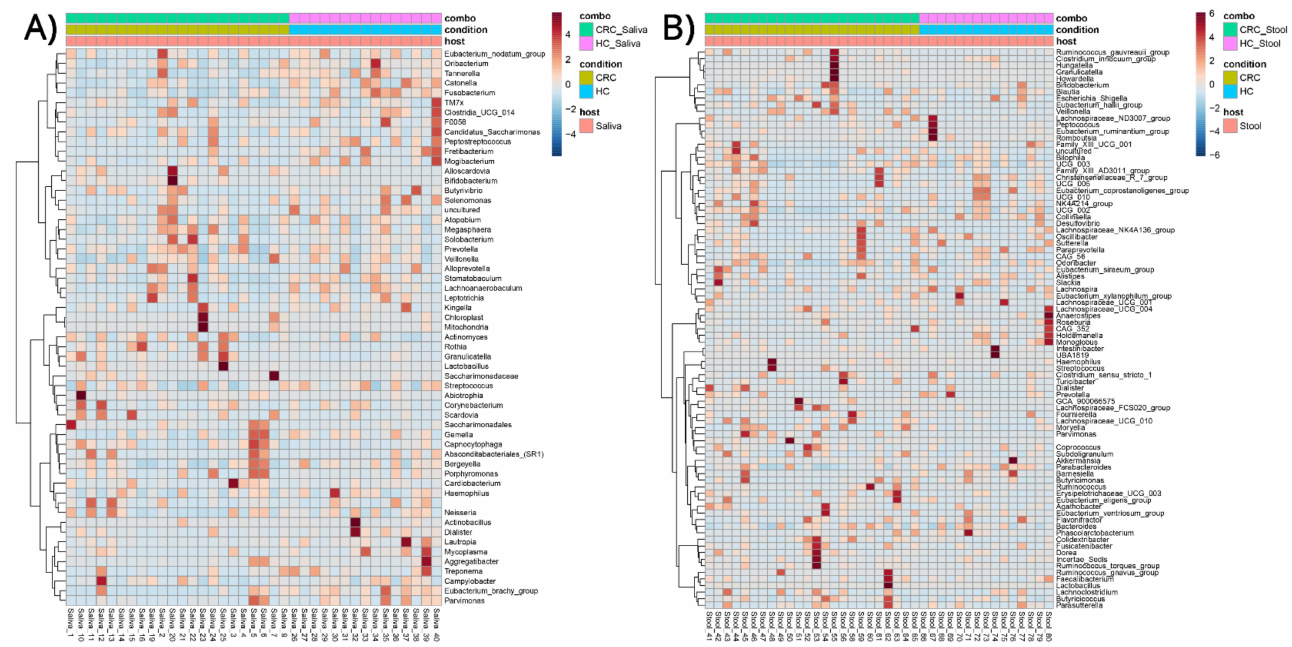
Figure 3. Clustered heatmap of bacterial genera–sample group associations in ( A ) saliva samples of colorectal cancer (CRC) patients and healthy controls (HCs) and ( B ) stool samples of colorectal cancer (CRC) patients and healthy controls